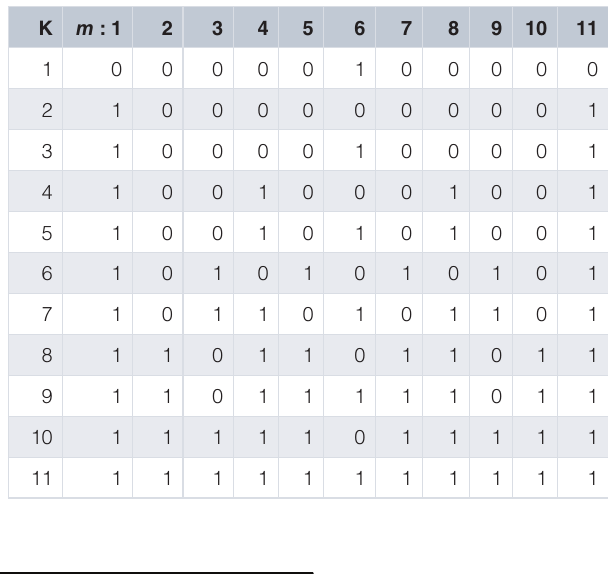
Table 1. Selecting K = 1 , · · · , M = 11 evenly spaced rate constants from λ : 0 and 1 denote α to be fixed to zero, and a free m parameter to be estimated, respectively (see equation (7)).